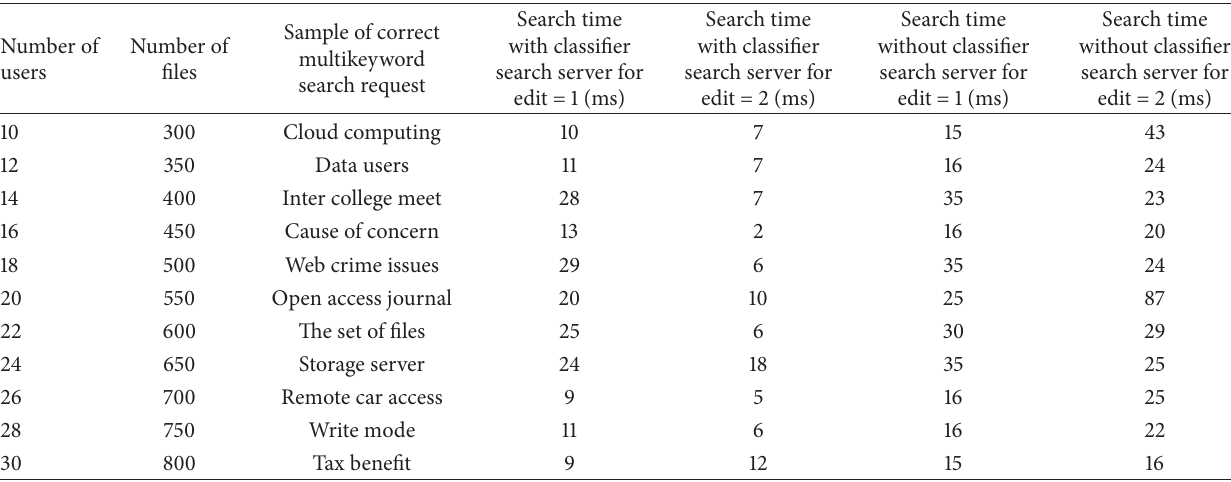
Table 4: Analysis of search efficiency for correct keywords with and without classifier search